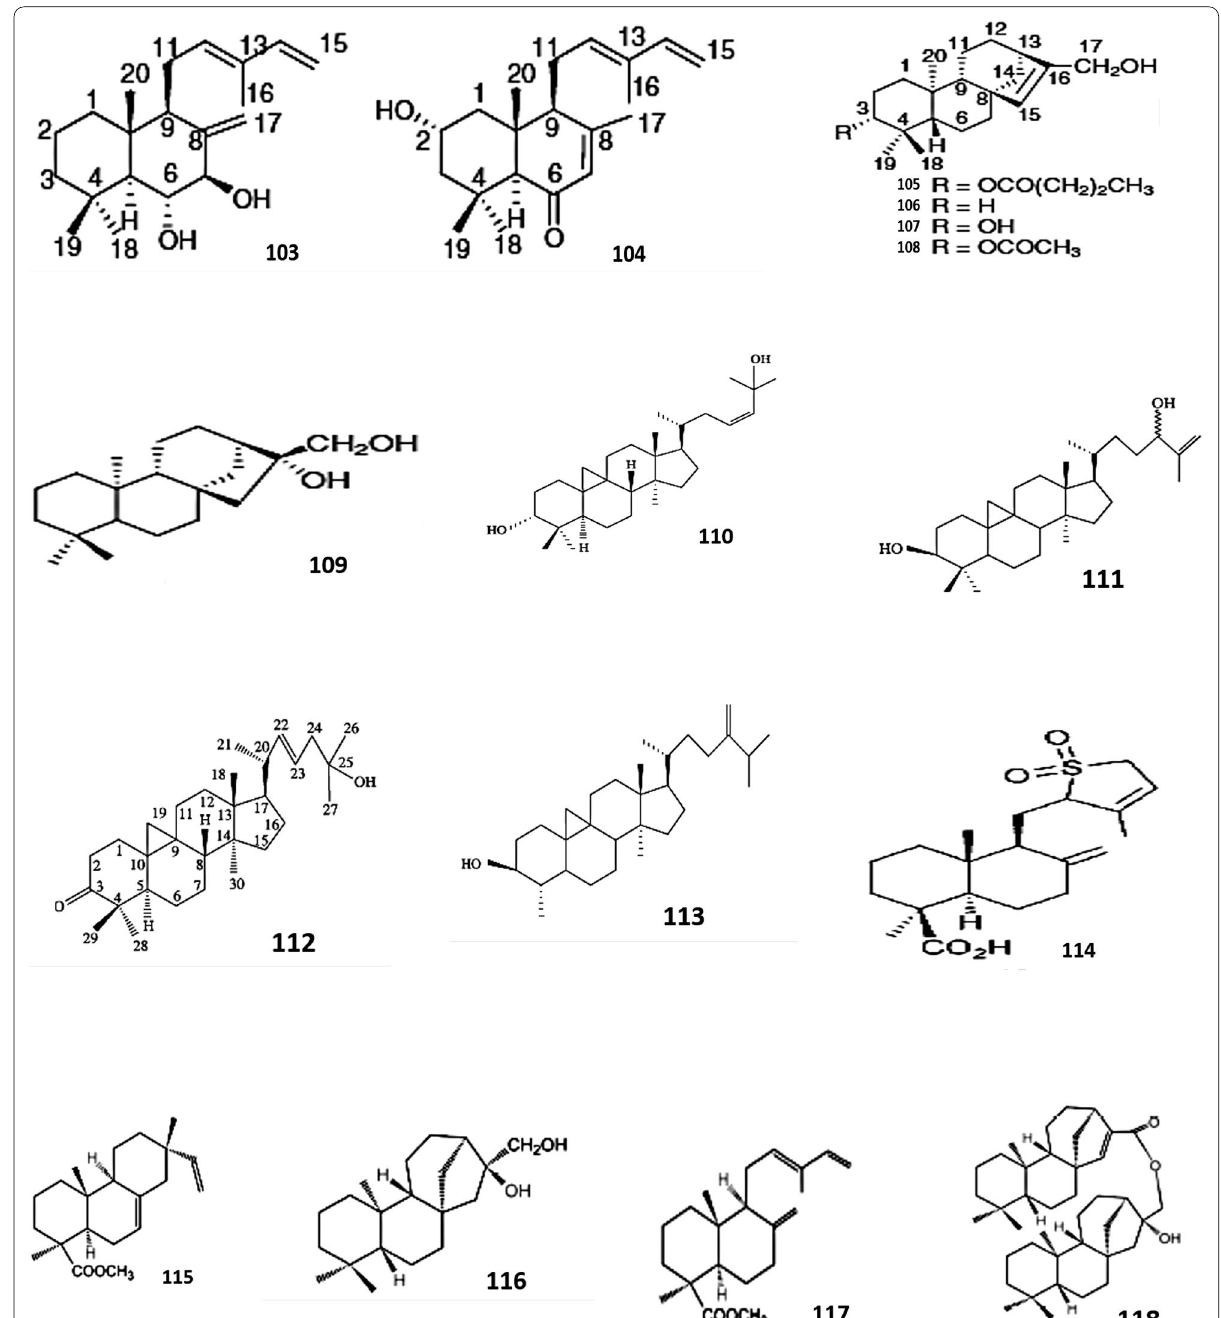
Fig. 2 Structures of various terpenoids of genus Fritillaria : 103. 6α,7β-dihydroxy-labda-8 (17),12(E),14-triene, 104. 6-oxo-2α-hydroxy-labda-7,12(E), 14-triene, 105. ent-3β-butanoyloxykaur-15-en-17-ol, 106. ent-kaur-15-en-17-ol, 107. ent-kaur-15-en-3β,17-diol, 108. ent-3β-acetoxykaur-15-en-17-ol, 109. ent-kauran-16β,17-diol, 110. triterpenoid (23z)- 9,19-cycloart-23-ene-3a,25-di-ol, 111. triterpenoid 9,19-cycloart-25-ene-3b,24j-diol, 112. triterpenoids 25-hydroxyl-9,19-cycloart-22-ene-3-one, 113. cycloeucalenol, 114. bicyclic diterpenoid labdane, 115. isopimaran-19-oic acid, methyl ester, 116. ent-16β, 17-epoxy-kaurane; ent-kauran-16α, 17-diol, 117. trans-comminic acid, methyl ester, 118. ent-15β,16-epoxy-kauran-17-ol and ent-16β-hydroxy-kauran-17-yl